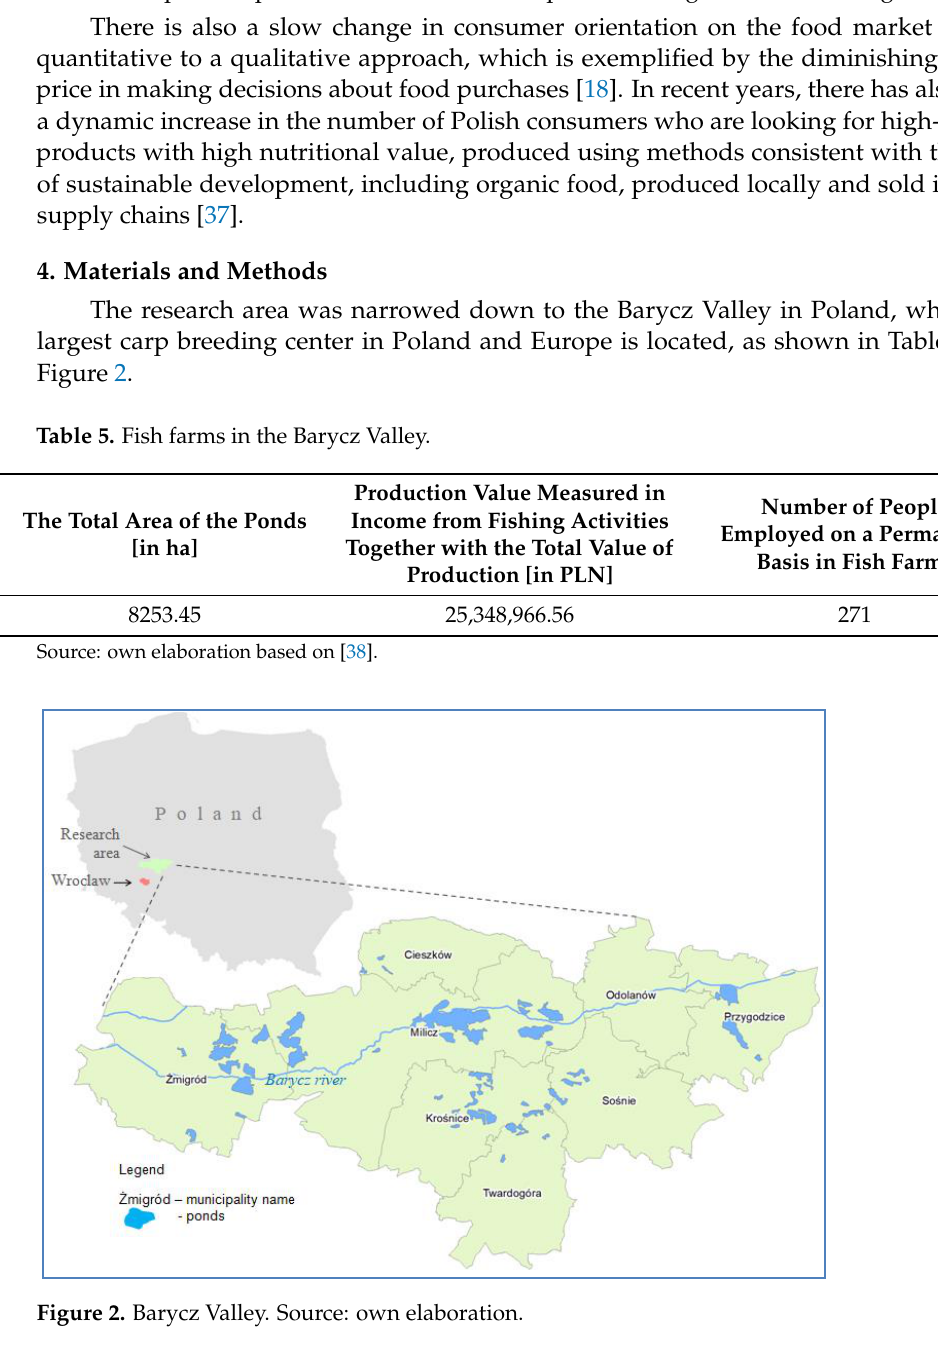
Products of the Minister of Agriculture and Rural Development [39]. It has become a key image element of the economic, natural and cultural offer in the Barycz Valley.